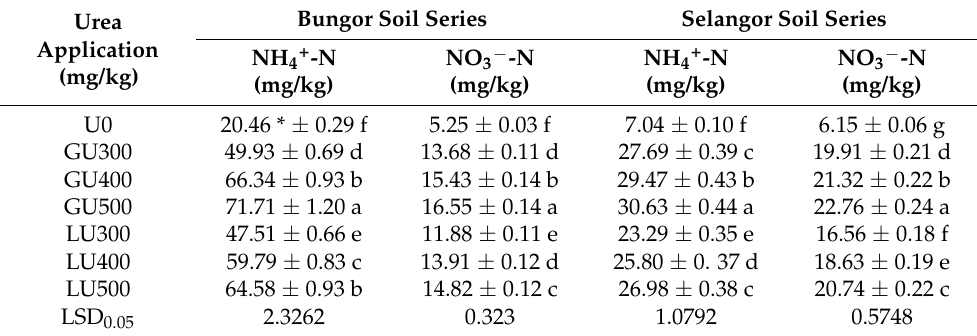
Table 2. Cumulative leaching loss of N (NH 4+ -N and NO 3 − -N) from applied urea.